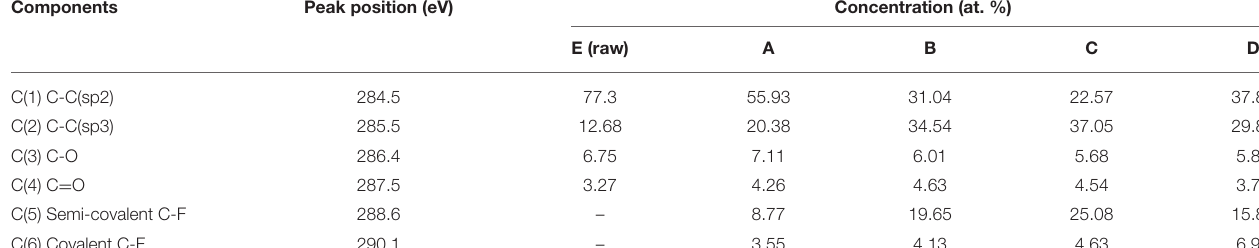
TABLE 2 | Parameters obtained from the deconvolution of the C1s peak of the XPS spectra. Components Peak position (eV) Concentration (at. %) E (raw)